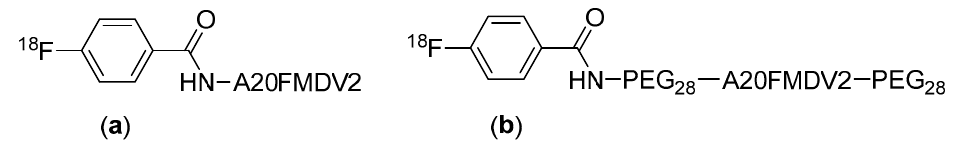
Figure 16. Structures of ( a ) [ 18 F]FBA-A20FMDV2 and ( b ) the bi-terminally PEGylated [ 18 F]FBA-PEG 28 -A20FMDV2-PEG 28 [107].